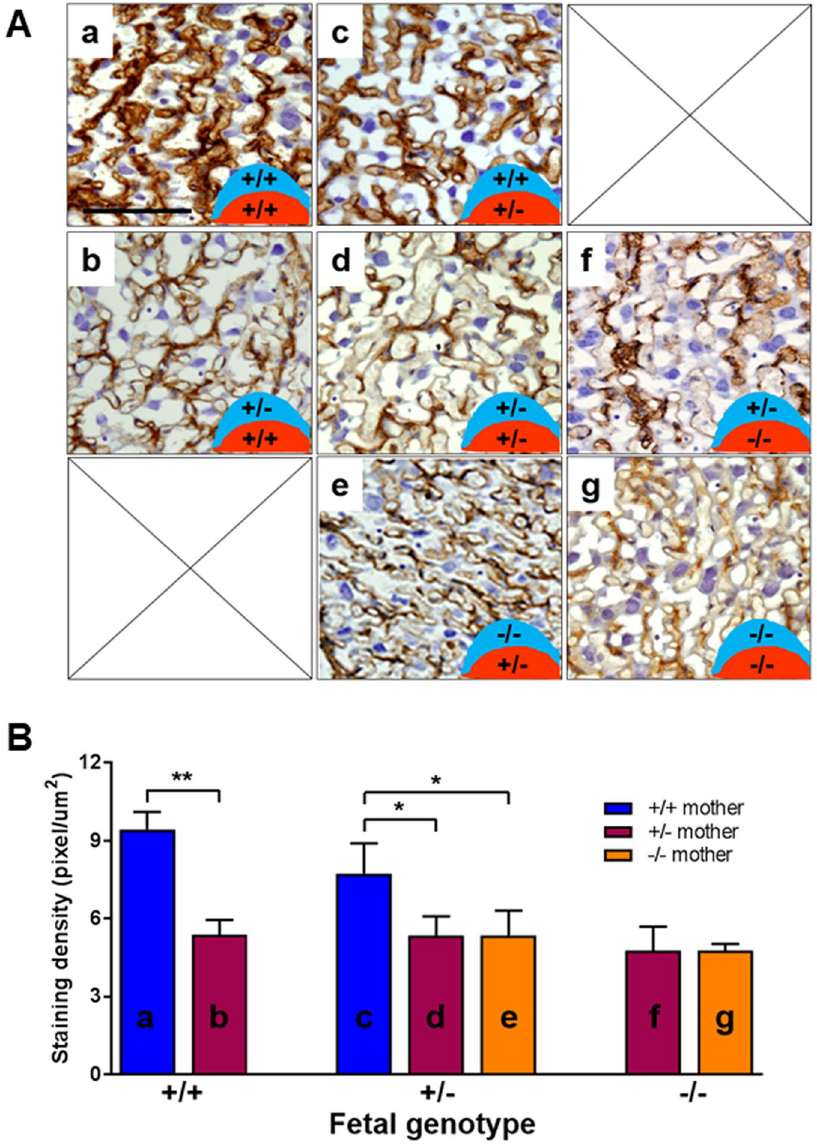
Figure 3. Analysis of fetal capillaries within the placental labyrinth at d16.5. ( A ) Representative images of immuno-staining for laminin to identify fetal capillaries. All 7 possible placental types illustrated in Fig. 2A are presented. The HtrA3 genotype of each placental type is schematically shown at the bottom right corner of each image, denoting the maternal decidua basalis genotype in blue on the top and the fetal placental genotype in red on the bottom. The labelling of individual type (a-g) is consistent with the labelling of Fig. 2D. ( B ) Quantitative analysis of laminin staining of the 7 distinctive placentas. Each type (a-g) is labelled consistently between ( A ) and ( B ). Data are expressed as mean ± SD. * p < 0.05, ** p <